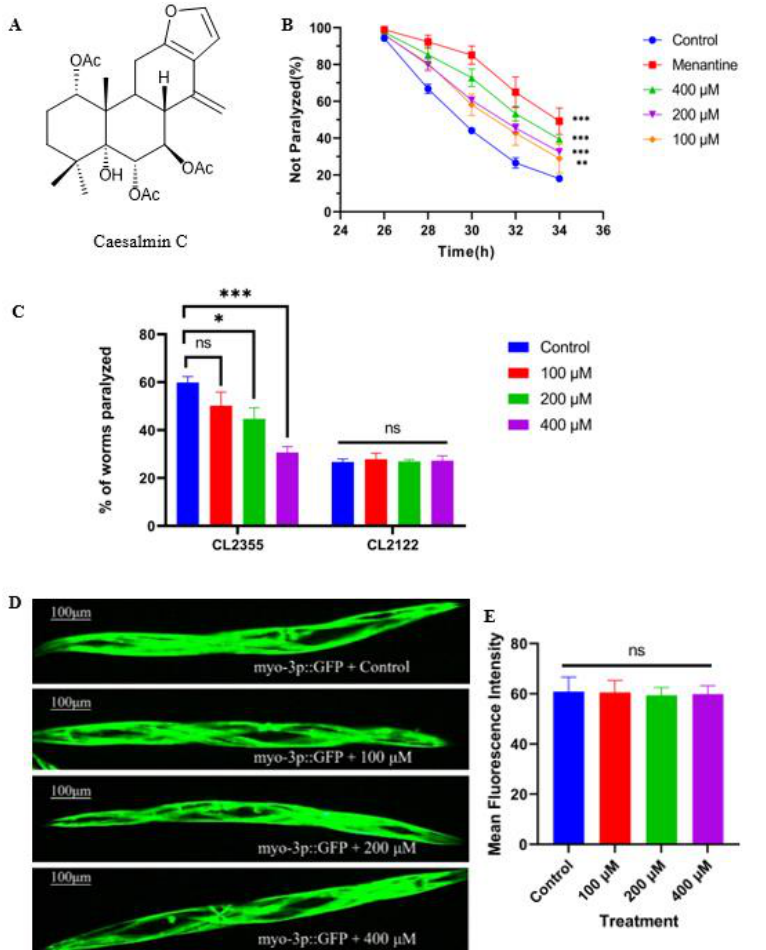
Figure 1. Caesalmin C alleviates paralysis symptoms in transgenic C. elegans expressing Aβ. ( A ) Chemical structure of caesalmin C. ( B ) The curves of the not paralyzed rate in each group. Transgenic CL4176 worms were treated with 100, 200, and 400 µM of caesalmin C, respectively. The 100 μM memantine was used as a positive control. ( C ) The effect of caesalmin C on hypersensibility to exogenous 5-HT in transgenic CL2355 worms. ( D ) The fluorescence pictures of CL2179 worms after treatment with different concentrations of caesalmin C. ( E ) The fluorescence intensity of GFP in CL2179 worms in each treated group. In all of the above, 0.1% ( v / v ) DMSO was used as control. Data are expressed as mean ± SD. p < 0.05 was considered statistically significant. The asterisk indicates significant difference compared to the respective control (ns p > 0.05, * p < 0.05, ** p <